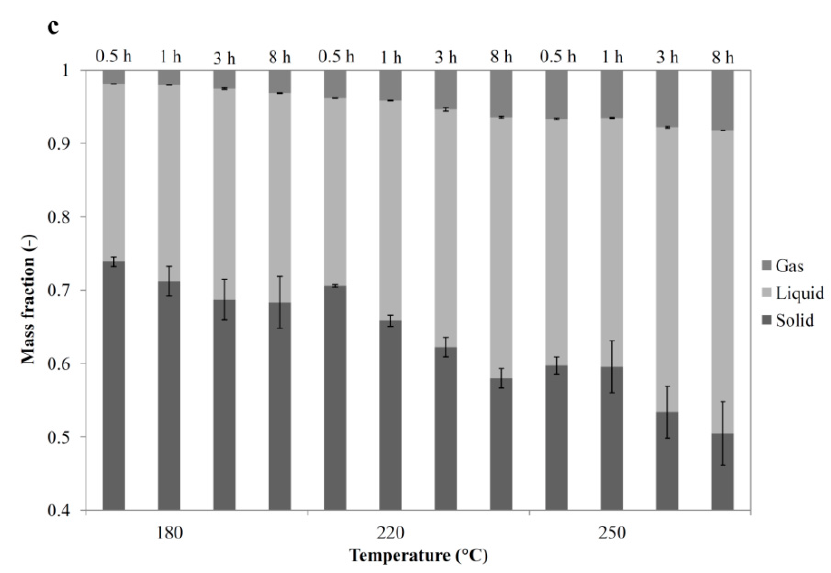
Figure 4. Overall balances for grape seeds ( a ), skins ( b ) and marc ( c ). At least two measurements were performed to evaluate the error bars.